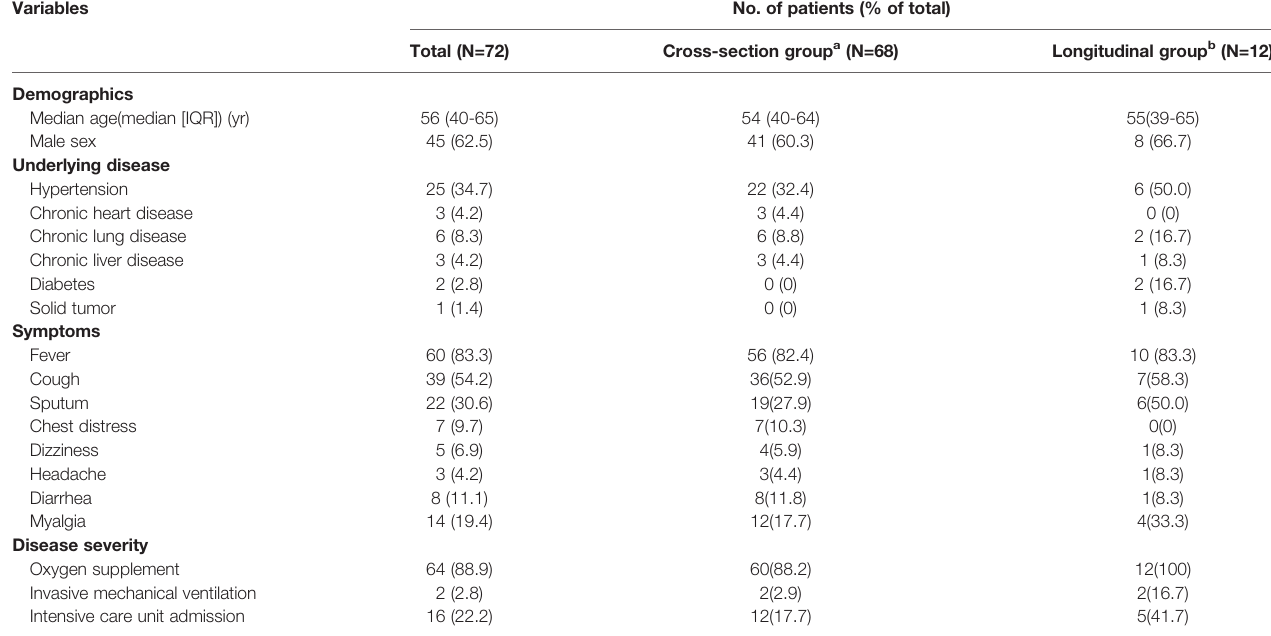
TABLE 2 | Demographics and clinical characteristics of enrolled patients.